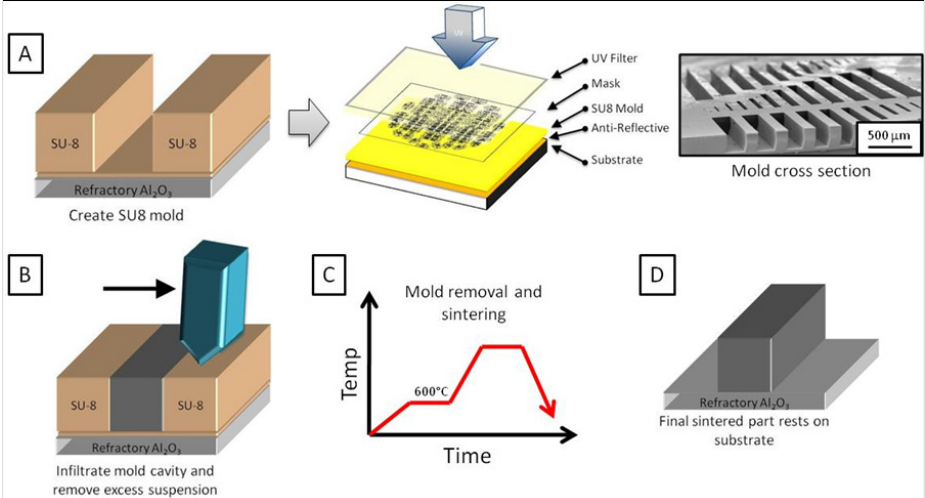
Figure 4. The LM-RIF process steps of mold fabrication, infiltration, mold and binder removal and sintering are depicted. (A) Molds are fabricated on high purity refractory substrates via a modified lithography technique. The lithography stack is shown, along with a cross sectional scanning electron micrograph of a sample mold. (B) The fabricated molds are then infiltrated with a high solids loading colloidal suspension via a screen printing squeegee and allowed to dry. (C) The mold and binder in the colloidal suspensions is removed at 600 ◦ C, followed by sintering, forming a dense final part. The specific furnace cycle is as follows: In ambient atmosphere, ramp 2 ◦ Cmin − 1 to 600 ◦ C and hold 2h. In an atmosphere of 5vol% H 2 and 95vol% N 2 , ramp 5 ◦ Cmin − 1 to 1300 ◦ C, hold 2h, and cool at 10 ◦ Cmin − 1 . (D) freestanding parts are left on the original